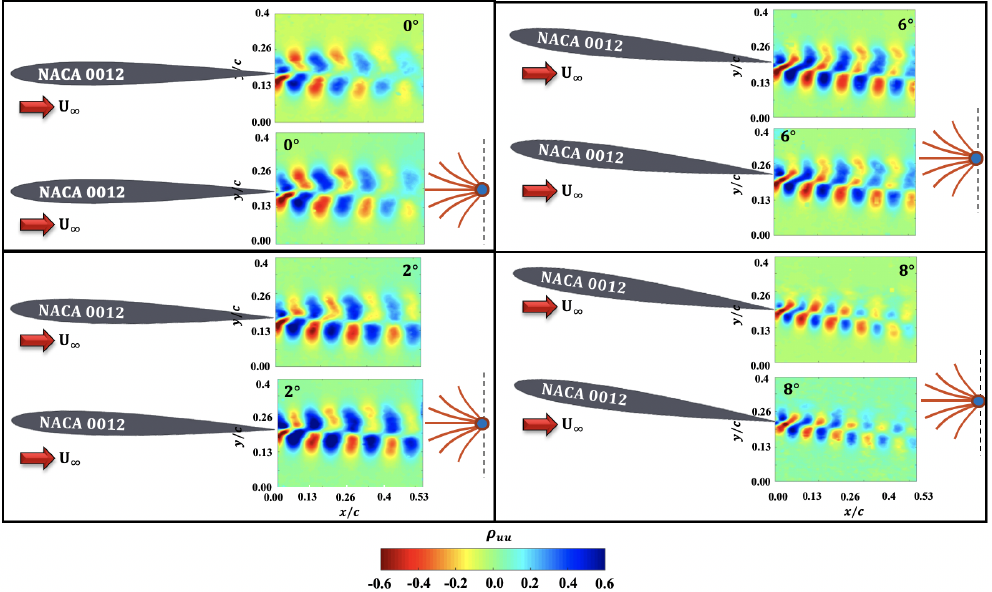
Figure 21. Two-point correlations of (transverse fluctuating velocity component) in the wake of NACA 0012 with and without